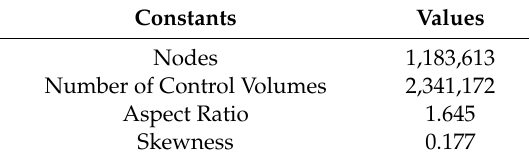
Figure 2. The representation computational mesh in an isometric perspective. Table 1. Characteristics of the generated computational mesh.